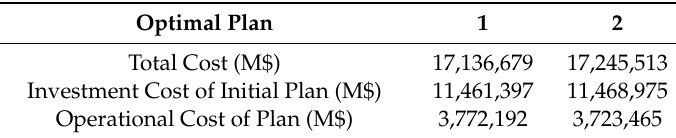
Table 11. Selected optimal design with the least-cost